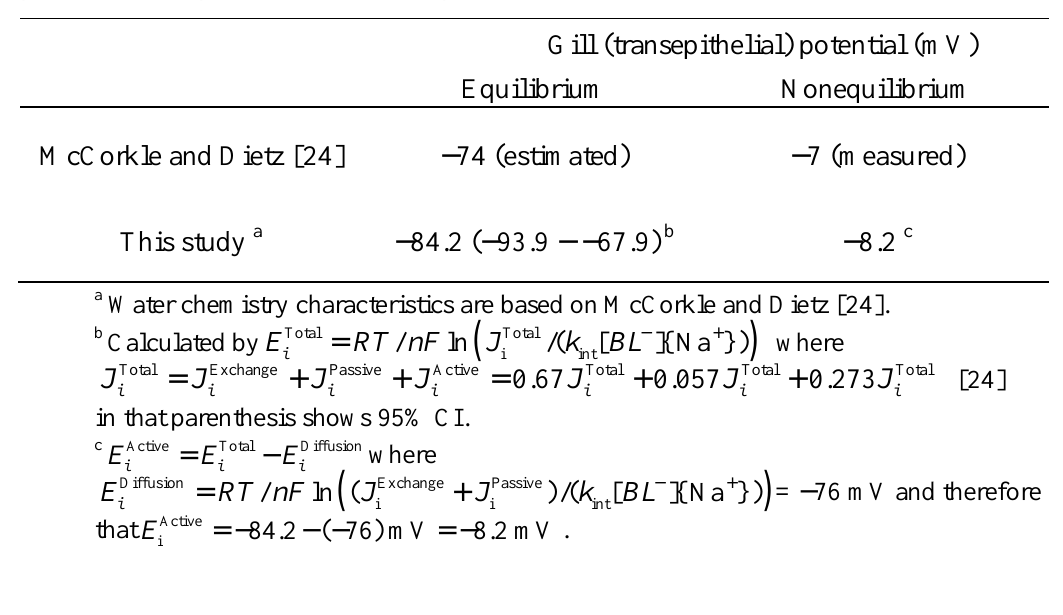
Table 1. Comparison between published data and our predicted values of clam gill potentials in equilibrium and nonequilibrium